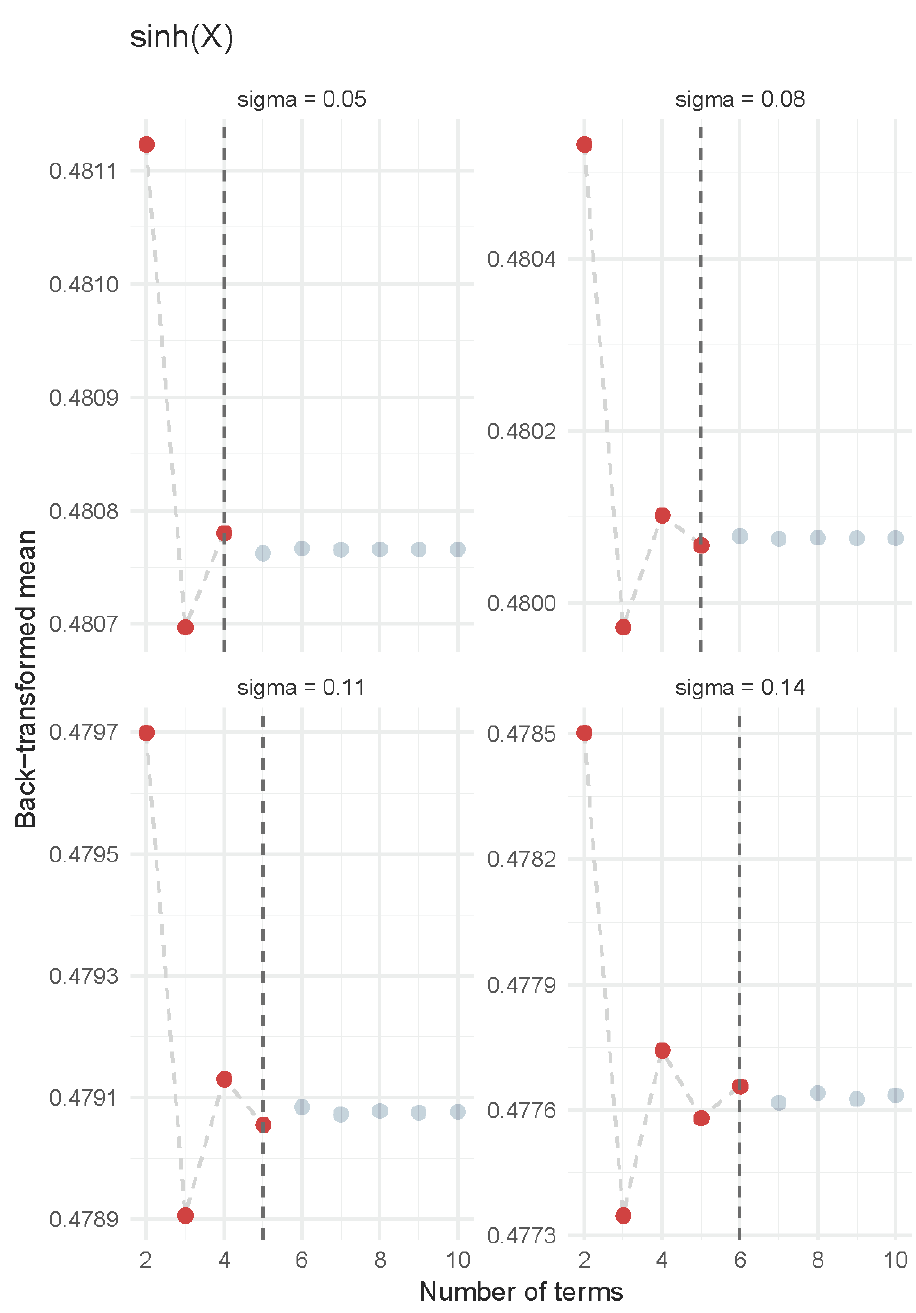
Figure 7. Convergence of the hyperbolic sine transformation according to the number of terms in the Taylor series expansion. The vertical dotted line identifies the number of terms for which two consecutive differences between Taylor series estimates are less than the preset value (order of 10 − 5 ).